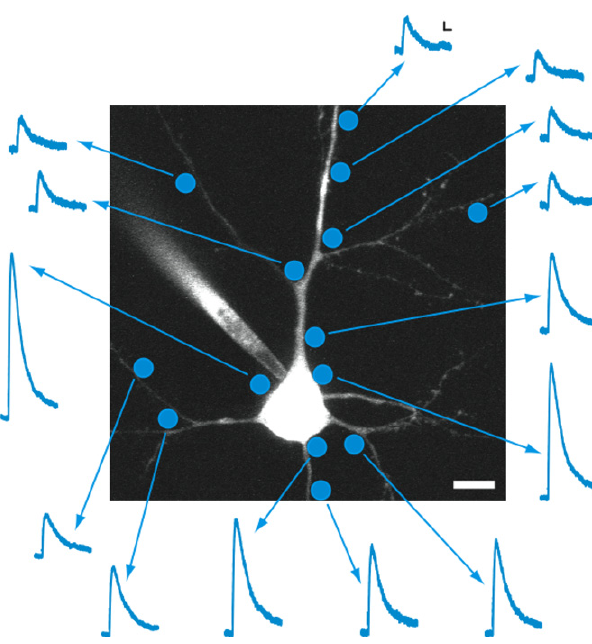
Figure 4 | Mapping GABAergic responses in individual neurons. Example of an experiment in which GABA receptor density mapping was attempted using 0.5 ms laser pulses of the same intensity at different positions along the cell body, dendrites, and axon of a layer 2/3 pyramidal neuron in mouse visual cortex. This example illustrates practical advantages and limitations regard- ing the spatial resolution of the technique. Scale bars: 5 pA, 50 ms, 10 μ